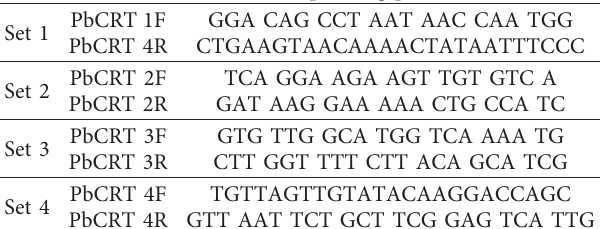
Table 3: Pb CRT sequencing